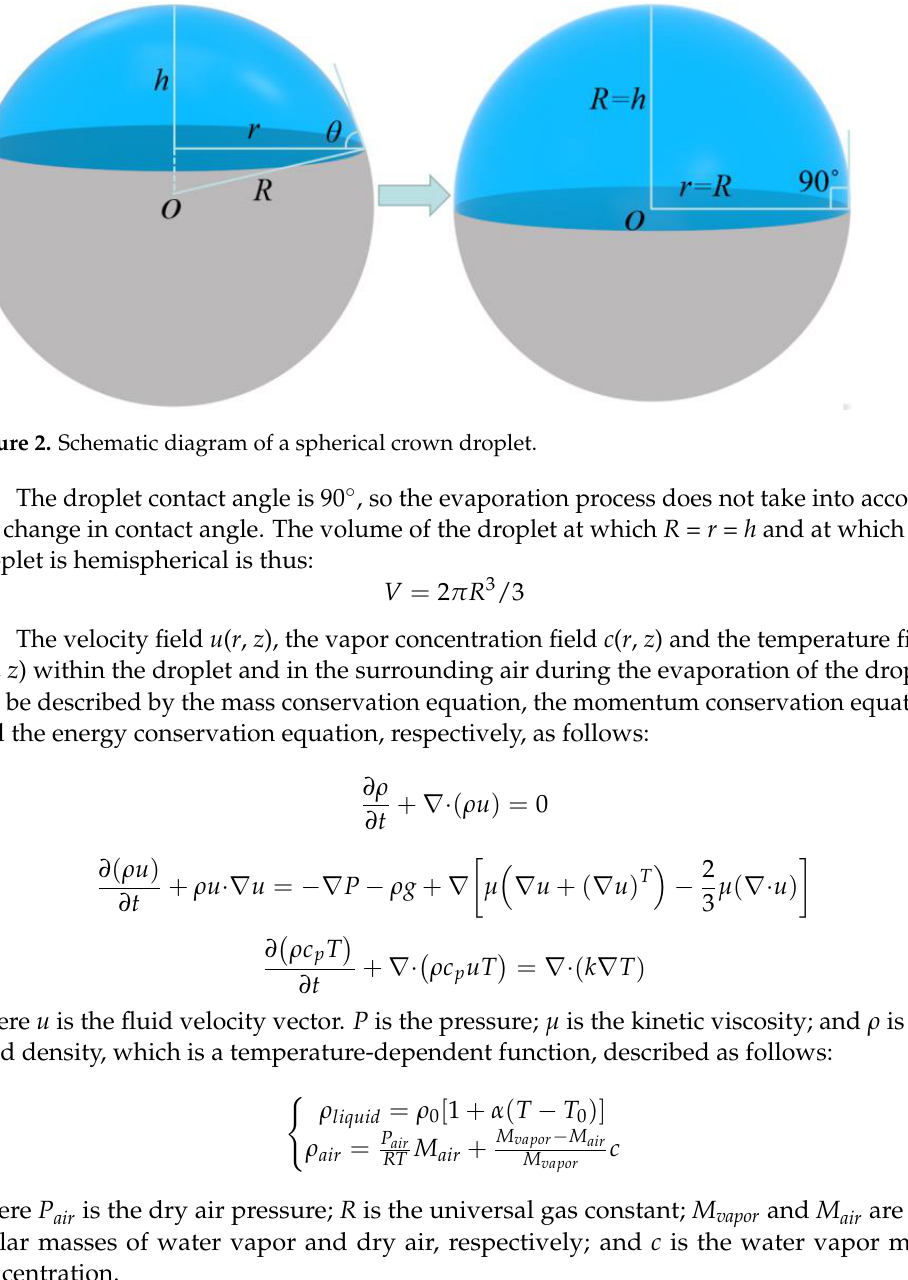
where P air is the dry air pressure; R is the universal gas constant; M vapor and M air are the molar masses of water vapor and dry air, respectively; and c is the water vapor mass concentration. The saturation vapor pressure is derived from the Antoine